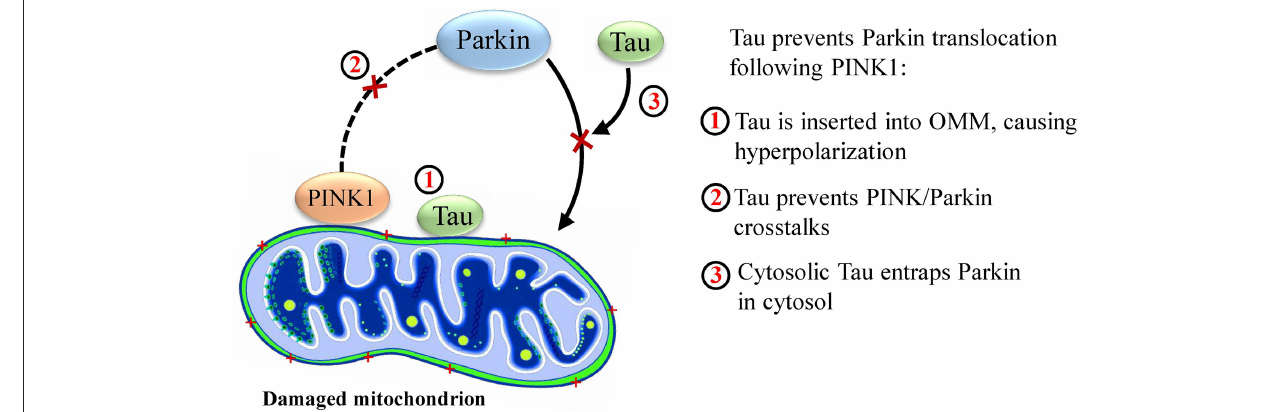
FIGURE 2 | Probable mechanisms by which Tau disrupts mitophagy.